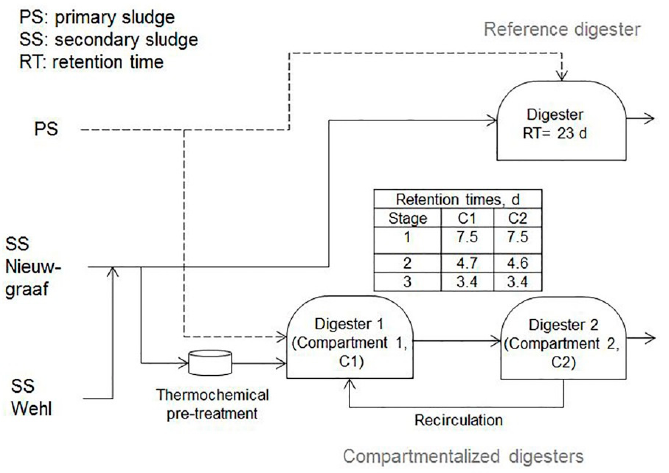
Figure 1. Scheme of the pilot-scale test.